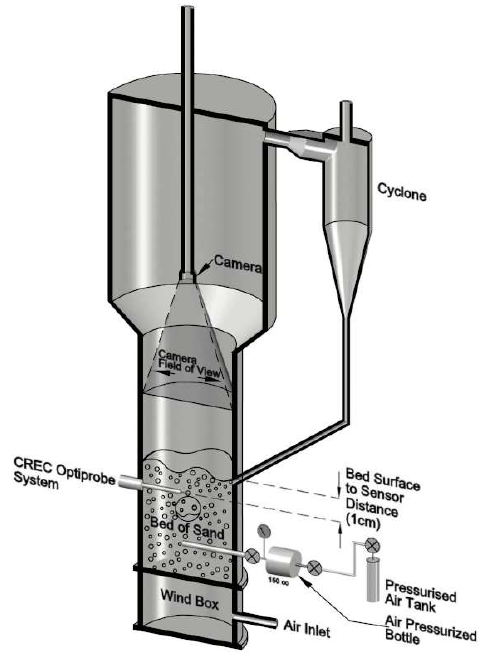
Figure 1. Fluidized bed unit operated at room temperature and near to atmospheric pressure by Torres Brauer (2020) [9]. Details provided show the position of the CREC-Optiprobe sensors.